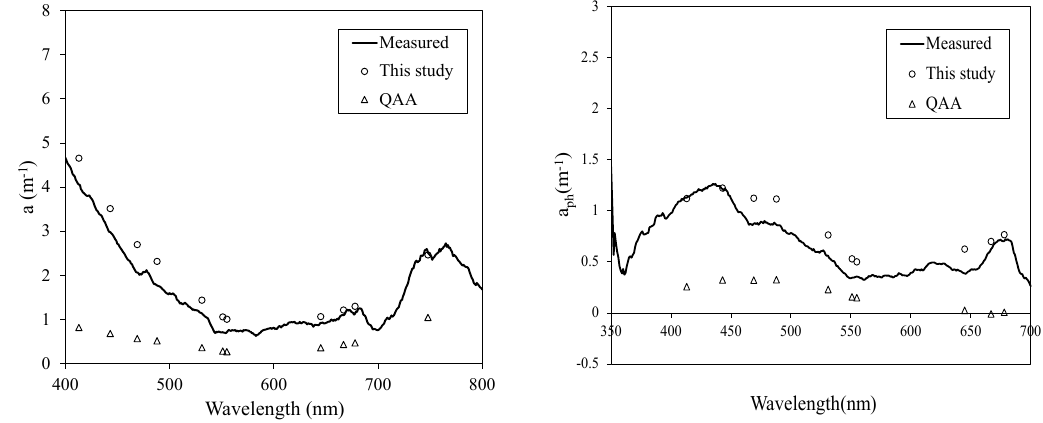
Figure12. ComparisonofQAA-retrieveda(a ph )versusmeasureddataandtheimprovedQAA-retrieved a (a ph ) versus measured